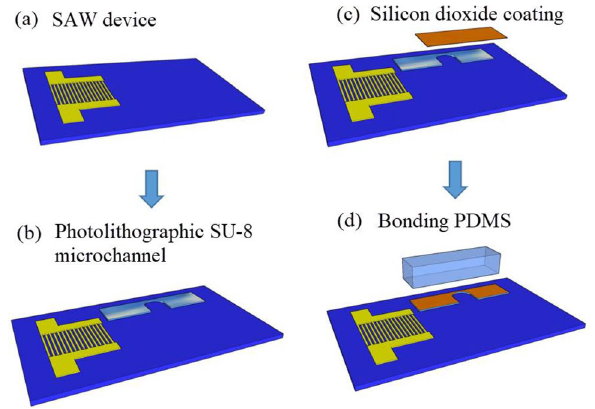
Figure 4. Schematic diagram of the fabrication scheme based on the SU-8 microchannel ( a ) SAW device. ( b ) Photolithography of SU-8 microchannels on the substrate surface. ( c ) Coating silicon dioxide film on the upper surface of the microchannel. ( d ) Bonding the PDMS layer with the microchannel to form a closed